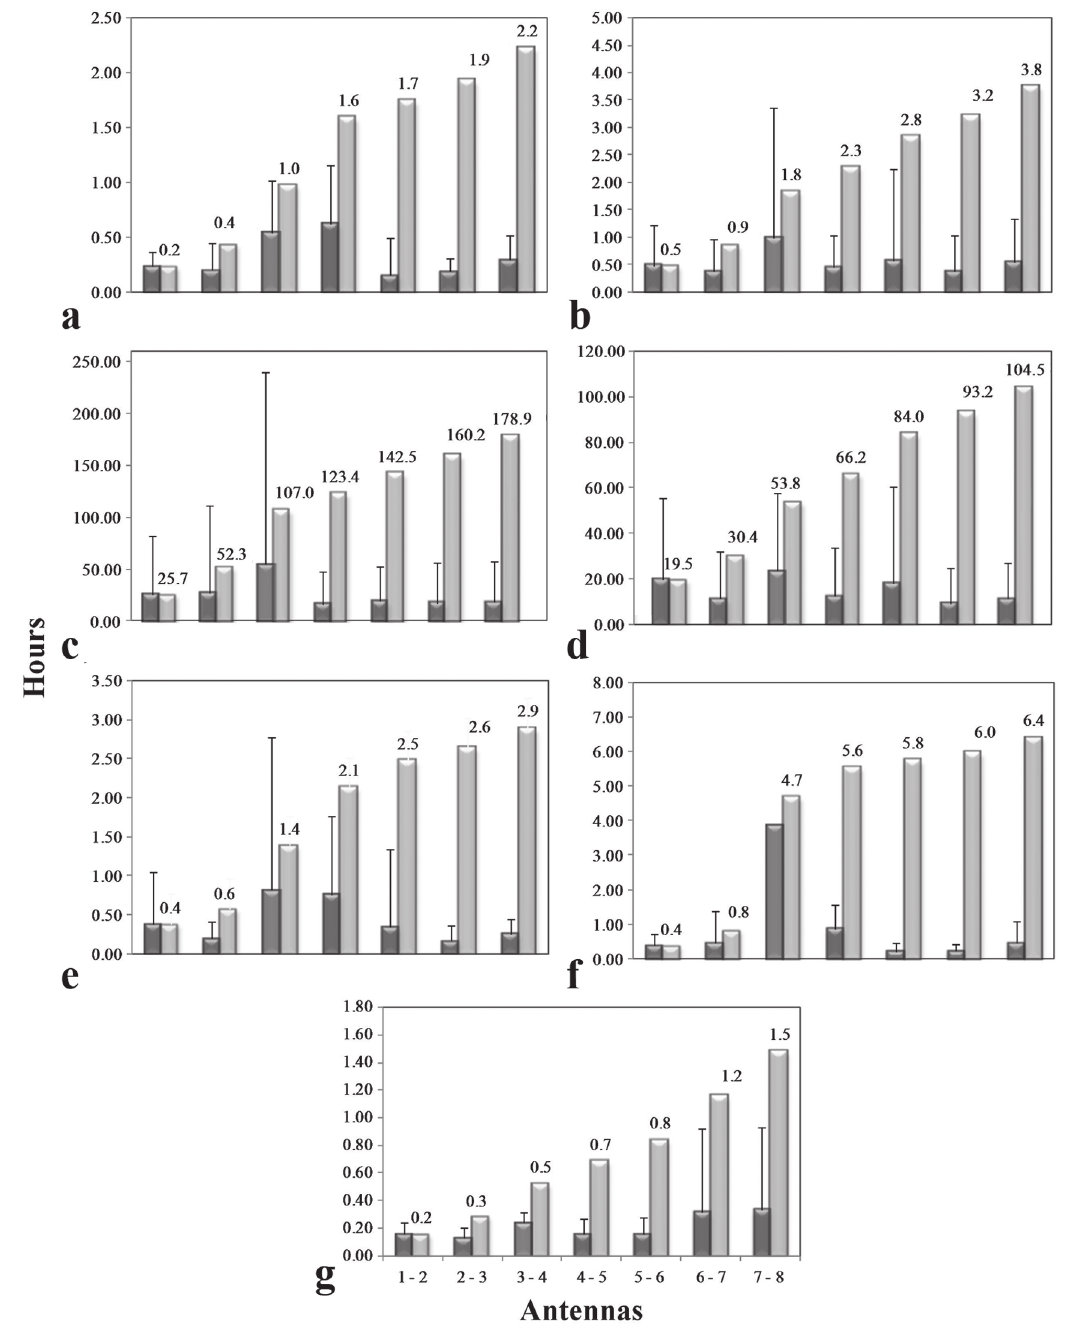
Fig. 6. Transit time between antennas (hours, dark gray bars) and cumulative transit time (hours, gray bars) for fish species released downstream and in the fish ladder. Bars represent mean + SD transit time of: a ) Piaractus mesopotamicus (downstream), b ) Piaractus mesopotamicus (fish ladder), c ) Rhinelepis aspera (downstream), d ) Rhinelepis aspera (fish ladder), e ) Brycon orbignyanus (downstream), f ) Prochilodus lineatus (fish ladder), g ) Prochilodus lineatus